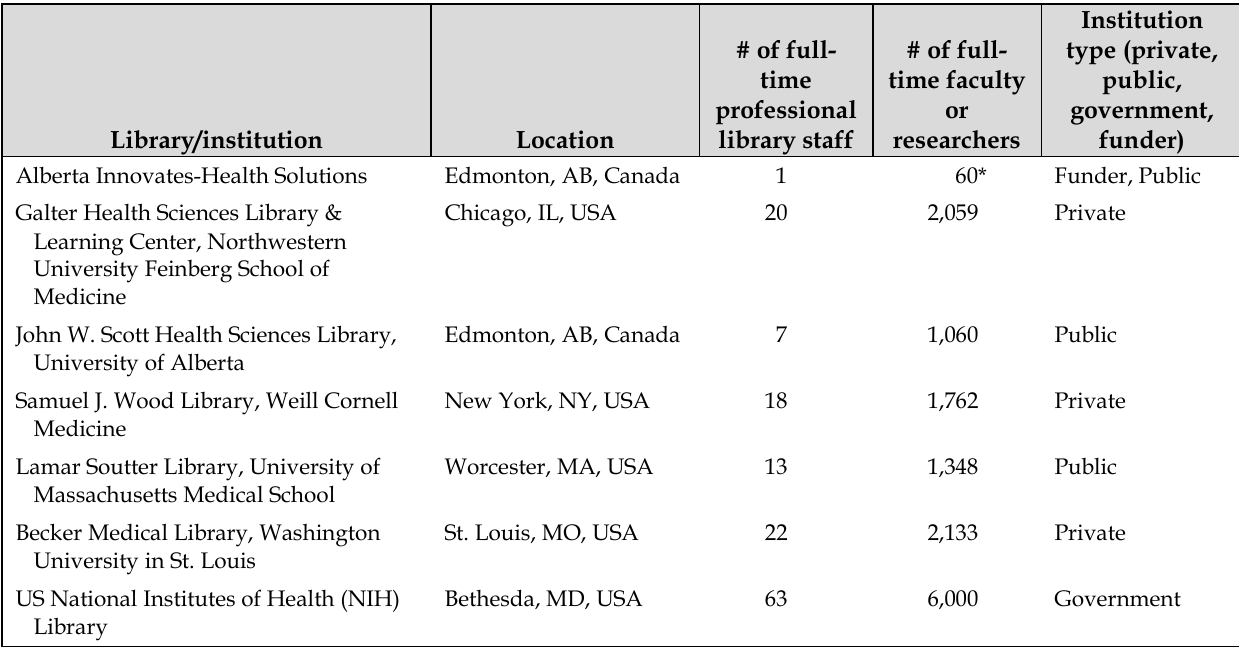
Table 1 List of institutions and